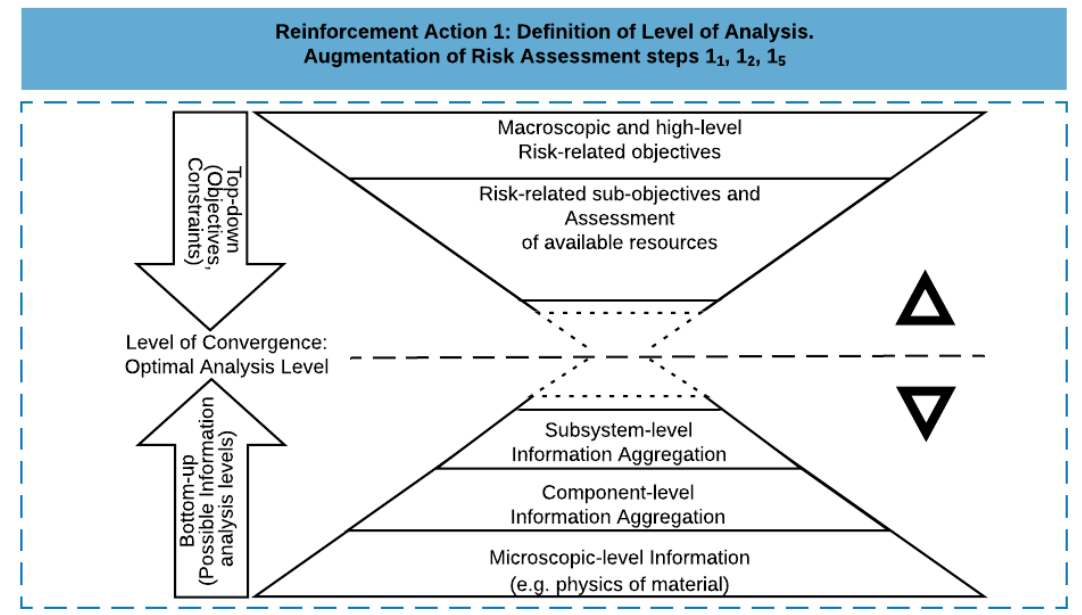
Figure 3. Level of analysis of a risk assessment defined as tradeoff decision between stakeholder expectations and analytical possibilities.